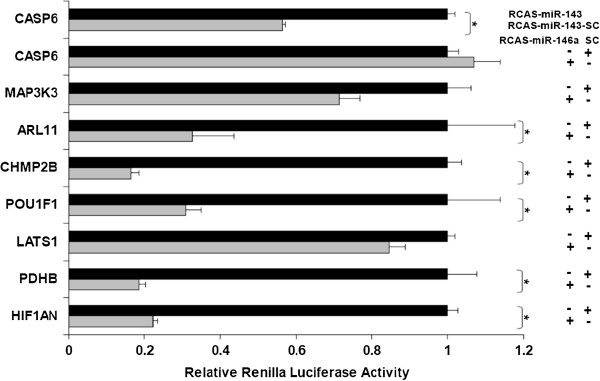
Validation of miR-146a target genes in the Renilla luciferase reporter system. Seven potential miR-146a target genes predicted by the miRanda algorithm were chosen for validation. For each predicted target gene a luciferase reporter vector was constructed in which the predicted miR-146a binding site was cloned into the 3’ UTR of a Renilla luciferase reporter gene. The Renilla luciferase activities were normalized to Firefly luciferase activities (under the control of an independent promoter). The relative expression of each Renilla luciferase target construct was compared between cells expressing miR-146a and those expressing the scrambled control sequence (SC) using a t-test for statistical significance (p < 0.05). Error bars indicate standard deviation. CASP6, a gene containing no binding site for miR-146a but predicted to contain a miR-143 target site was used as negative control.